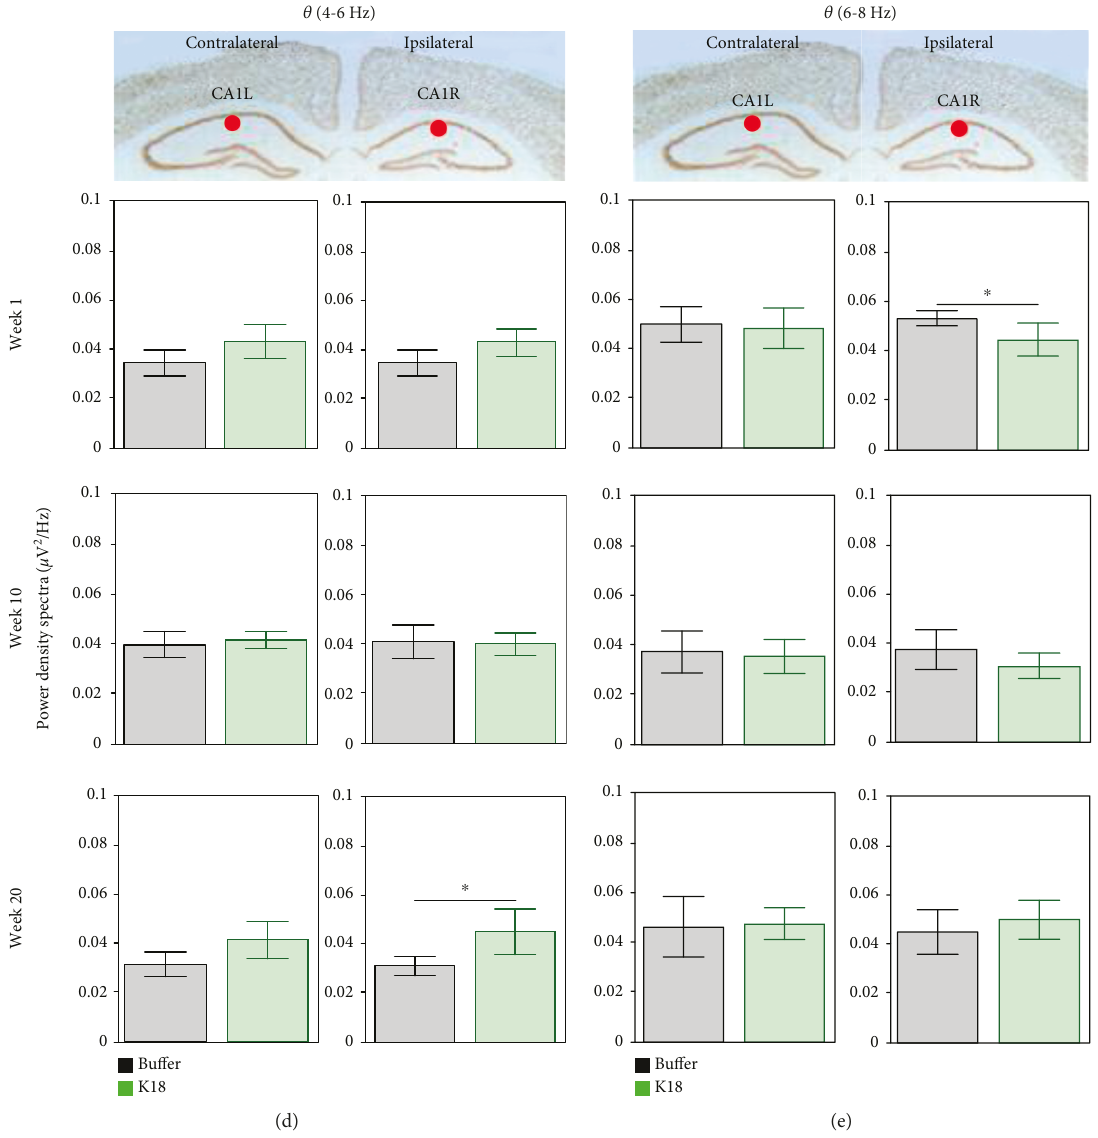
Figure 1: (a) Scheme showing the placement of recording electrodes and a cannula for injection of K18 in the locus coeruleus. (b, c) Relative power spectra in frequency (1-20 Hz (b) and 20-100 Hz (c)) for the CA1R and CA1L electrodes for bu ff er- (black, n = 7 ) and K18- (green, n = 8 ) injected mice, at recording weeks 1, 10, and 20. Insets indicate total relative power with no signi fi cance between group di ff erences (two-sample t -test) at 1-20 Hz and 20-100 Hz in b1 and b2, respectively. (d, e) Relative power spectra in CA1R and CA1L in low (4-6 Hz (d)) and high (6-8 Hz (e)) theta oscillations at recording weeks 1, 10, and 20. Data are presented as mean (across animals) values (and 95% CI). Horizontal lines above bar plots with asterisks indicate the presence of signi fi cant di ff erence between bu ff er- and K18-injected animals (two-sample t -test; ∗ p value < 0 05